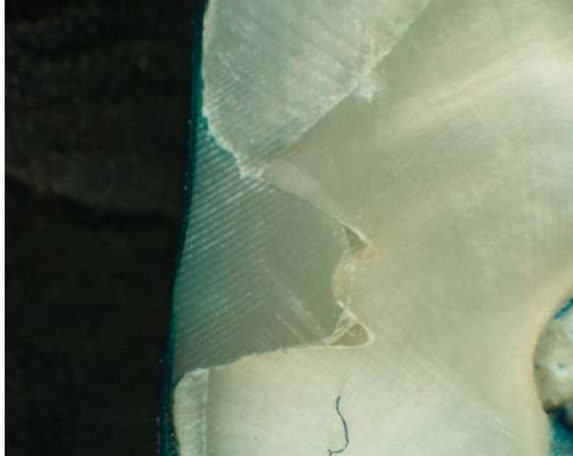
Figure 4- Photomicrograph of gamma group (laser) showing micro leakage (score